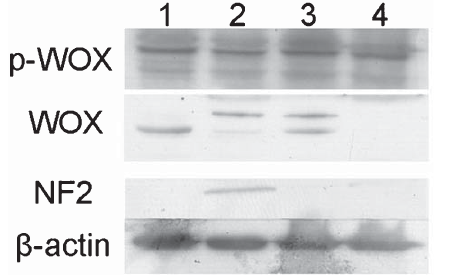
Fig. 9. Western blot data showing 2-immunoreactive bands for WOX1andWOX2inmeningiomas,1and3fromtransitionalcase,2 for microcystic type and 4 from atypical type. The results are similar to those of Fig. 8 and